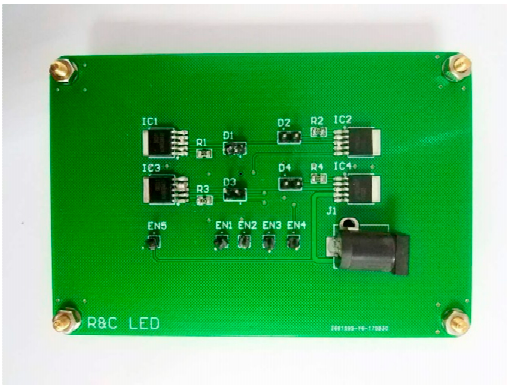
Figure 8. The circuit board of transmitting terminal.